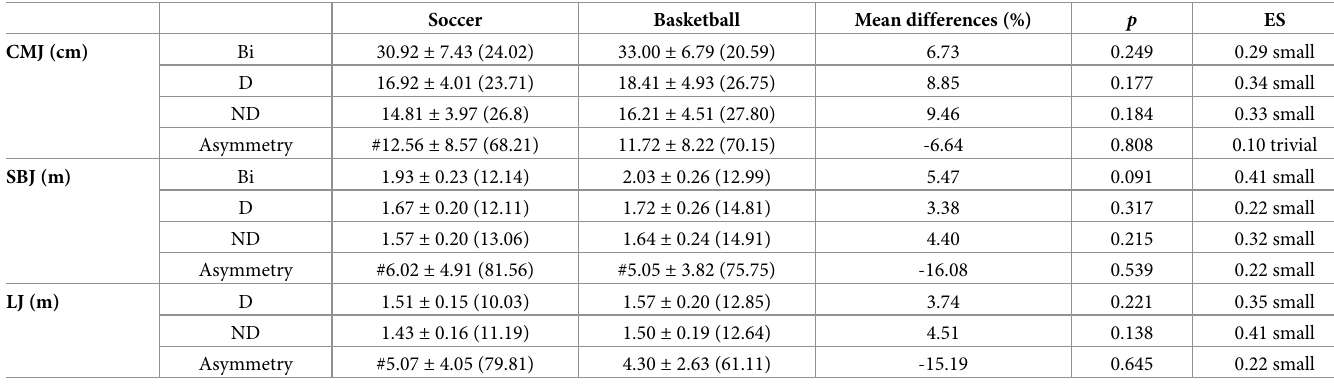
Table 1. Summary of results obtained during jumping tests. Soccer Basketball Mean differences (%) p